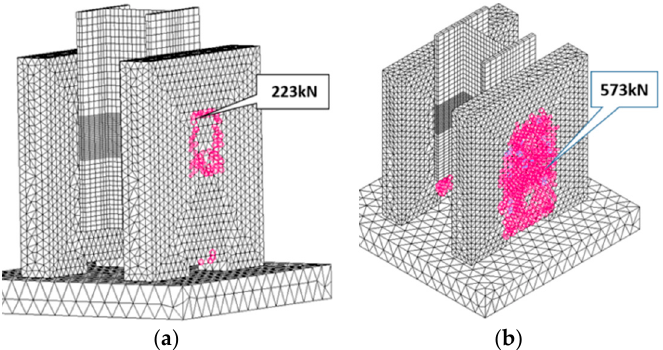
Figure 11. The ordinary concrete specimen theoretical cracking under relatively small intermediary loading ( a ) and at the final stage ( b ).